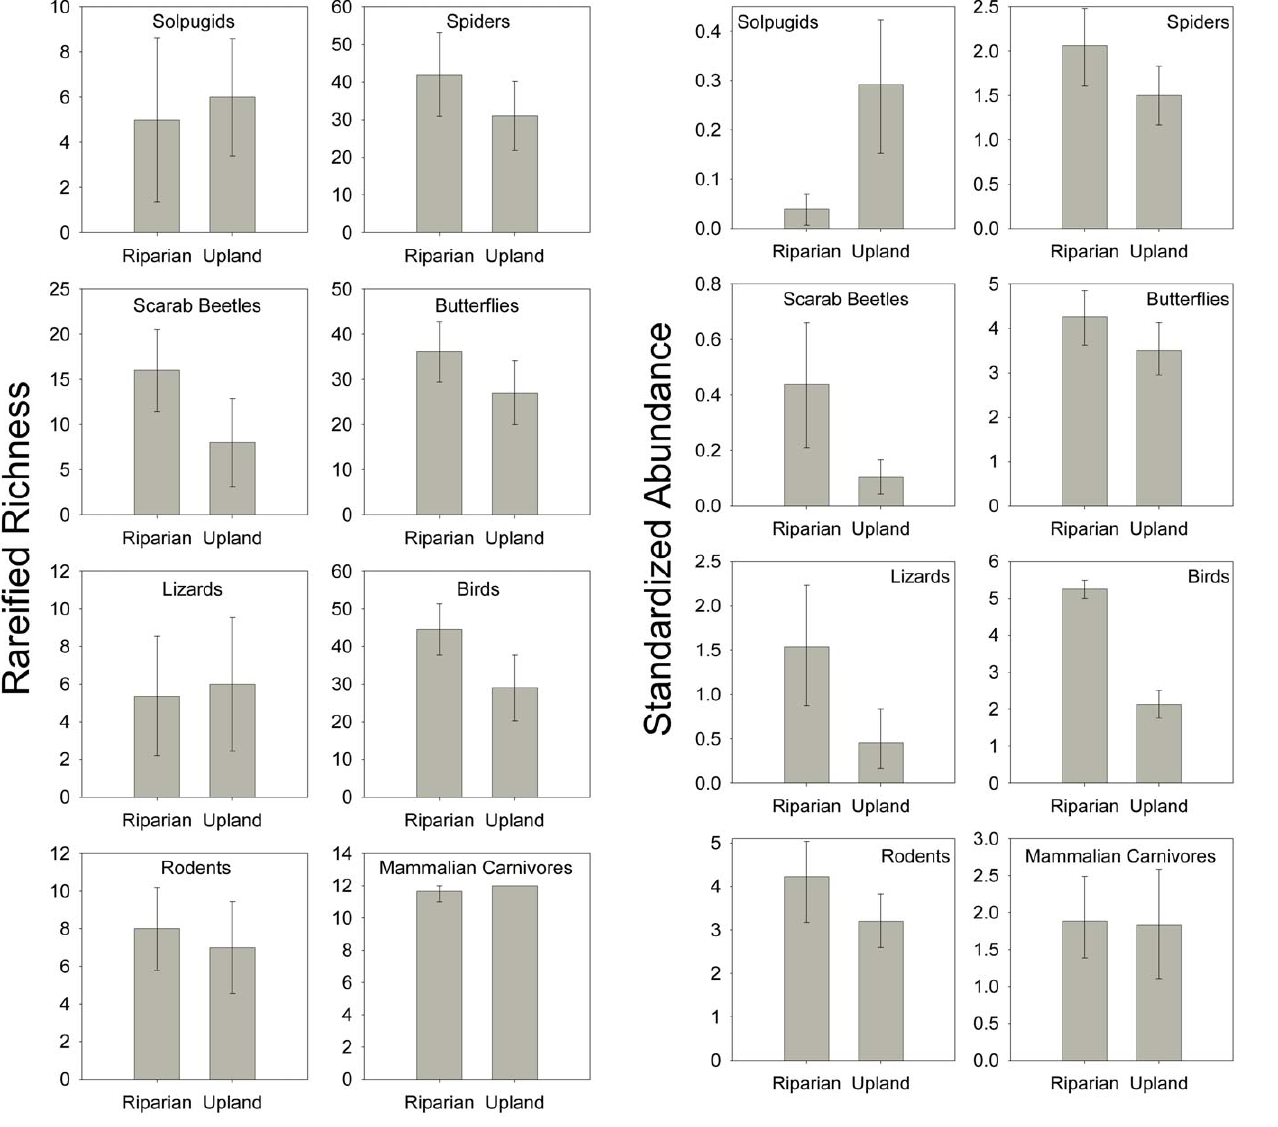
Figure 5. Richness by zone for each taxonomic group. Mau Tau rarefied richness values ( 6 95% confidence intervals) for the eight taxa sampled in both riparian and upland zones along the upper San Pedro River. The only values that had non-overlapping 95% confidence intervals were birds in riparian and upland zones.